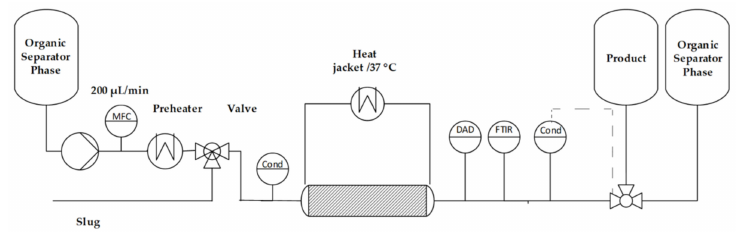
ethyl oleate and the slug (see Figure